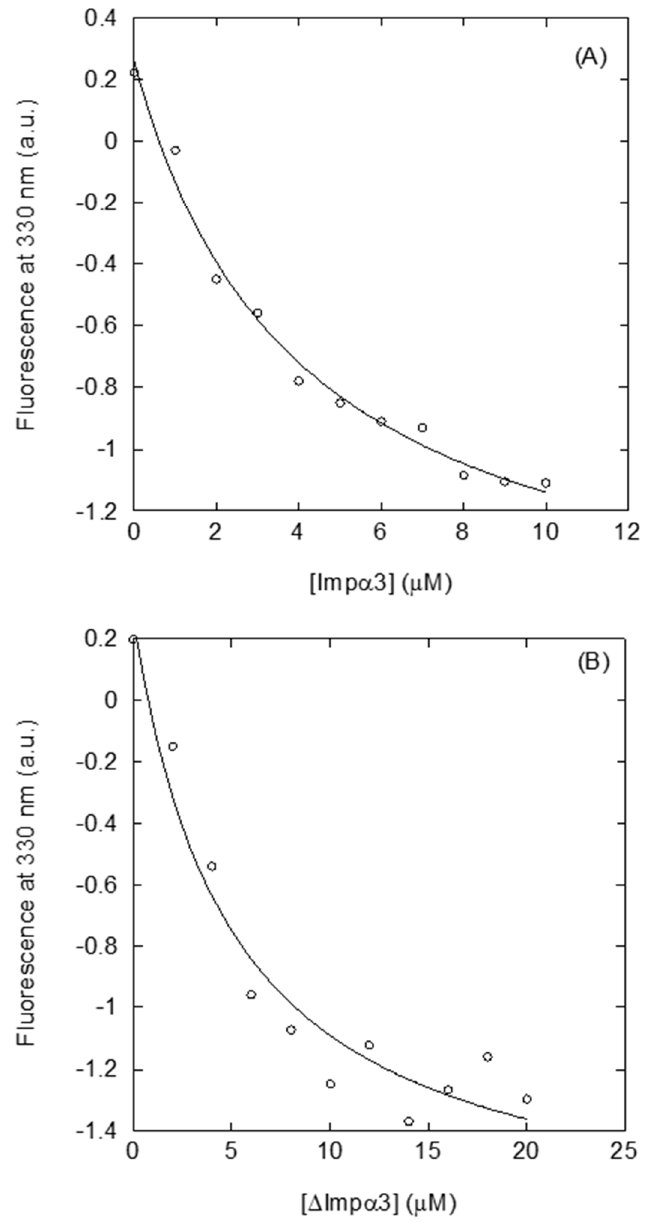
Figure 2. Interaction of intact NUPR1L with both importin species as measured by fluorescence: ( A ) Titration curve monitoring the changes of Imp α 3 fluorescence at 330 nm in the presence of NUPR1L, after excitation at 280 nm. ( B ) Titration curve monitoring the changes of ∆ Imp α 3 fluorescence at 330 nm in the presence of NUPR1L, after excitation at 280 nm. All experiments were carried out in phosphate buffer (50 mM, pH 7.0).